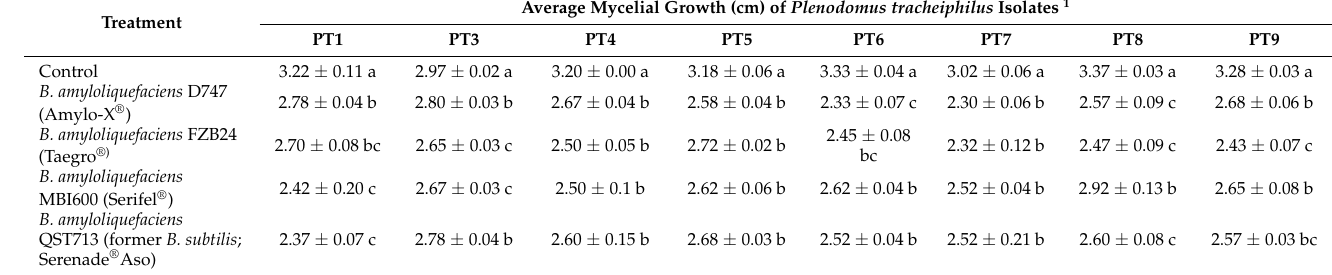
Table 3. In vitro effects of selected antagonistic bacterial VOCs in terms of reducing mycelial diameter in eight representative Plenodomus tracheiphilus